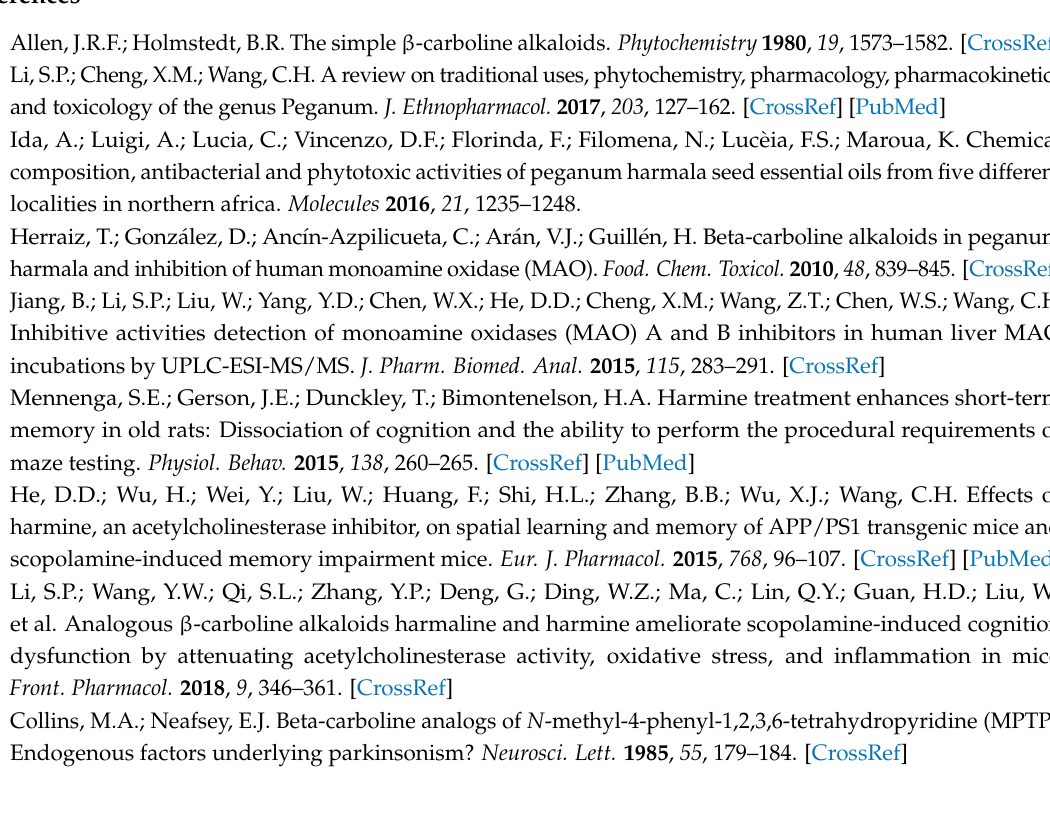
s1, Figure S1: Representative MRM chromatograms of HAR, MEM, HOL and IS in rat plasma: (A) a blank plasma; (B) a blank sample spiked with the analytes (with LLOQ) and IS (40.0 ng/ml); and (C) a plasma sample (2.0 min) from a rat after the co-administration of medium dose (40.0 mg/kg) HAR with 5.0 mg/kg MEM.; Table S1: MS/MS conditions for multiple reaction monitoring of MEM, HAR, HOL and IS; Table S2: LLOD, LLOQ and representative calibration curves of each standard substance (n = 5); Table S3: Summary of within-run and between-run precision for the UPLC-MS/MS method (n = 6); Table S4: Summary of extraction yield and matrix effect for the UPLC-MS/MS method (n = 6); Table S5: Stability of each standard substance in rat plasma under different storage conditions (n =